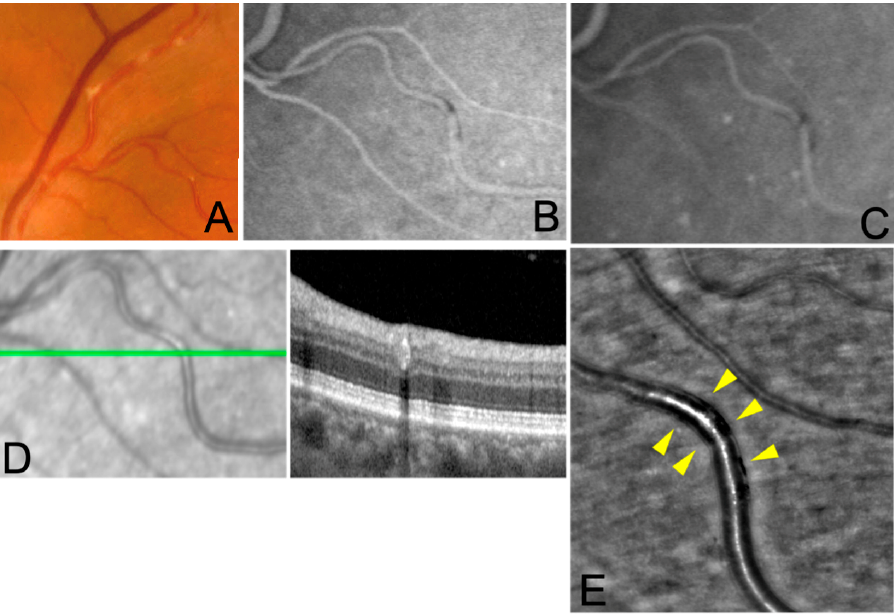
Figure 2. Multimodal imaging of case 2. A 61-yo healthy man was diagnosed with VZV posterior uveitis confirmed through RT-PCR analysis on aqueous tap (2,292,000 genomes/mL) and was then treated with oral valacyclovir 2 g three times daily and corticosteroids. ( A ) KP can be detected along retinal arteries on FP, of note the venous vasculature is spared; ( B , C ) KP appear as hypo/iso fluorescent lesions in both early and late phase in FA and ICGA; ( D ) focal hyperreflectivity of the arterial wall on OCT with underlying hyporeflective signal; ( E ) segmental hyporeflectivity (yellow arrowheads) is clearly visible within the artery wall.